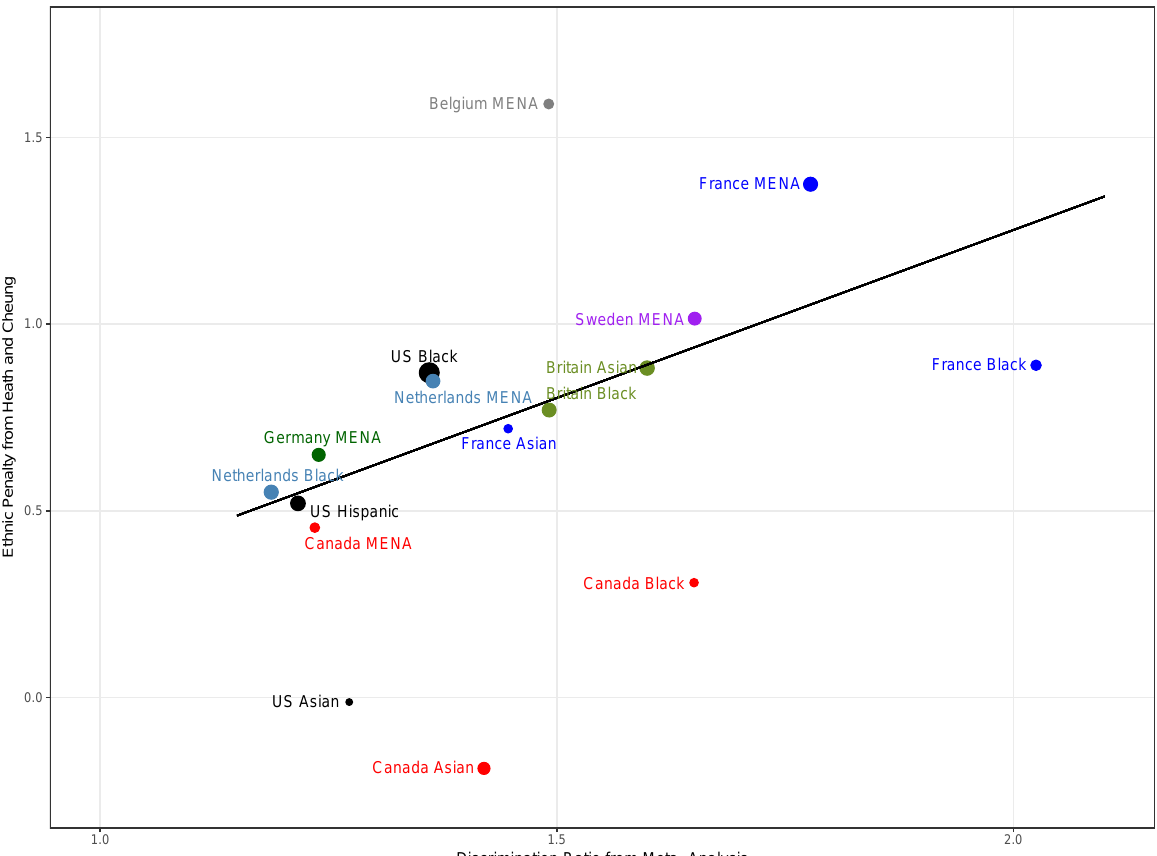
Figure 4: Ethnic Penalty and Discrimination by Country and Target Group